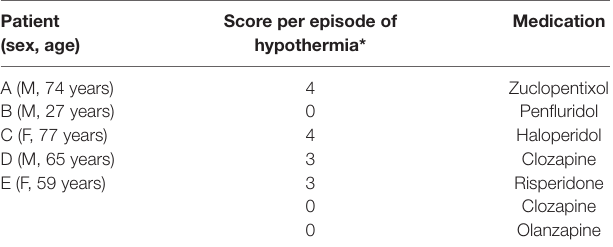
TABLE 2 | Patient scores on the Naranjo Adverse Drug Reaction Probability Scale. Patient (sex,